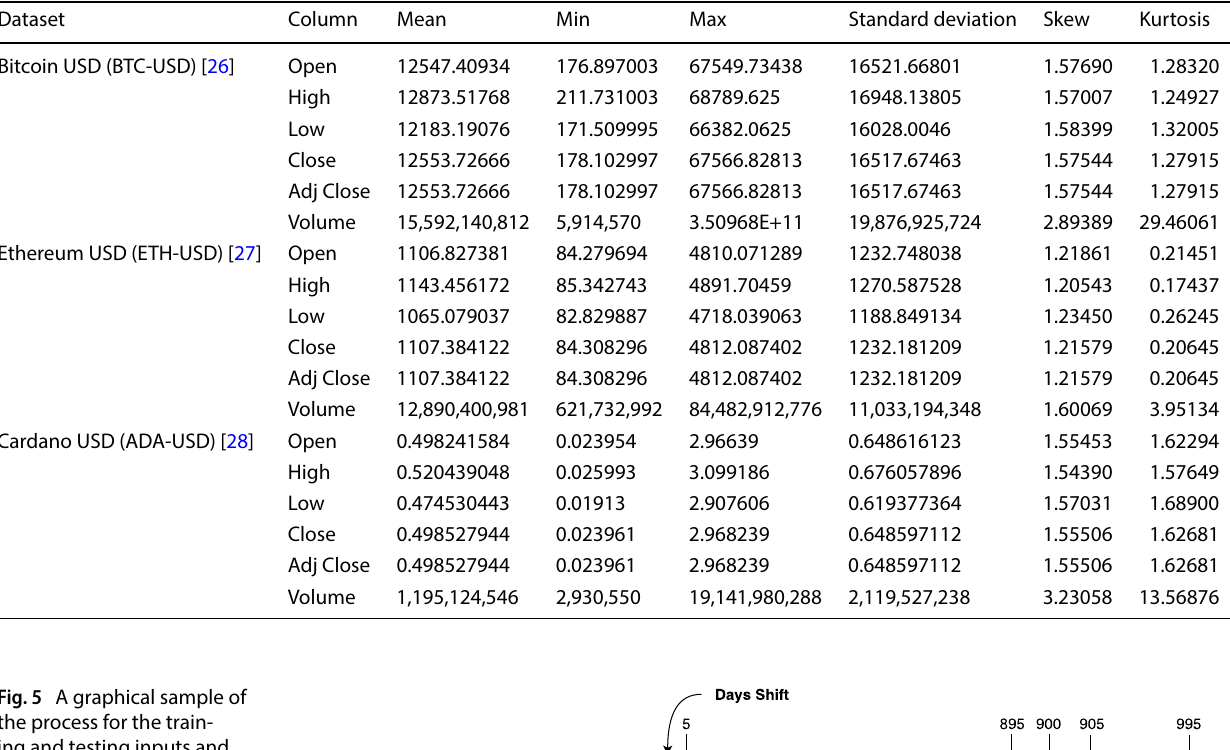
Fig. 5 A graphical sample of the process for the train- ing and testing inputs and